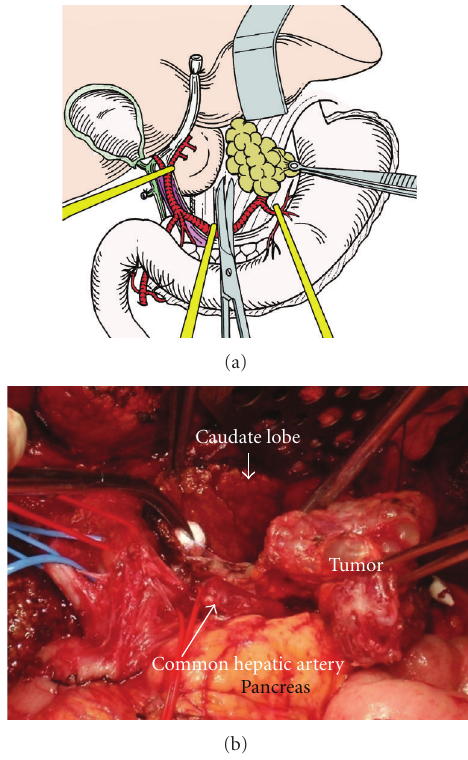
Figure 11: Dissection of the tumor in the superior omental recessus. By traction of tumors to the left side, the capsule of the caudate lobe is cut and the tumors with liver capsule and retroperitoneum are dissected from the caudate lobe, left crural muscle, and vena